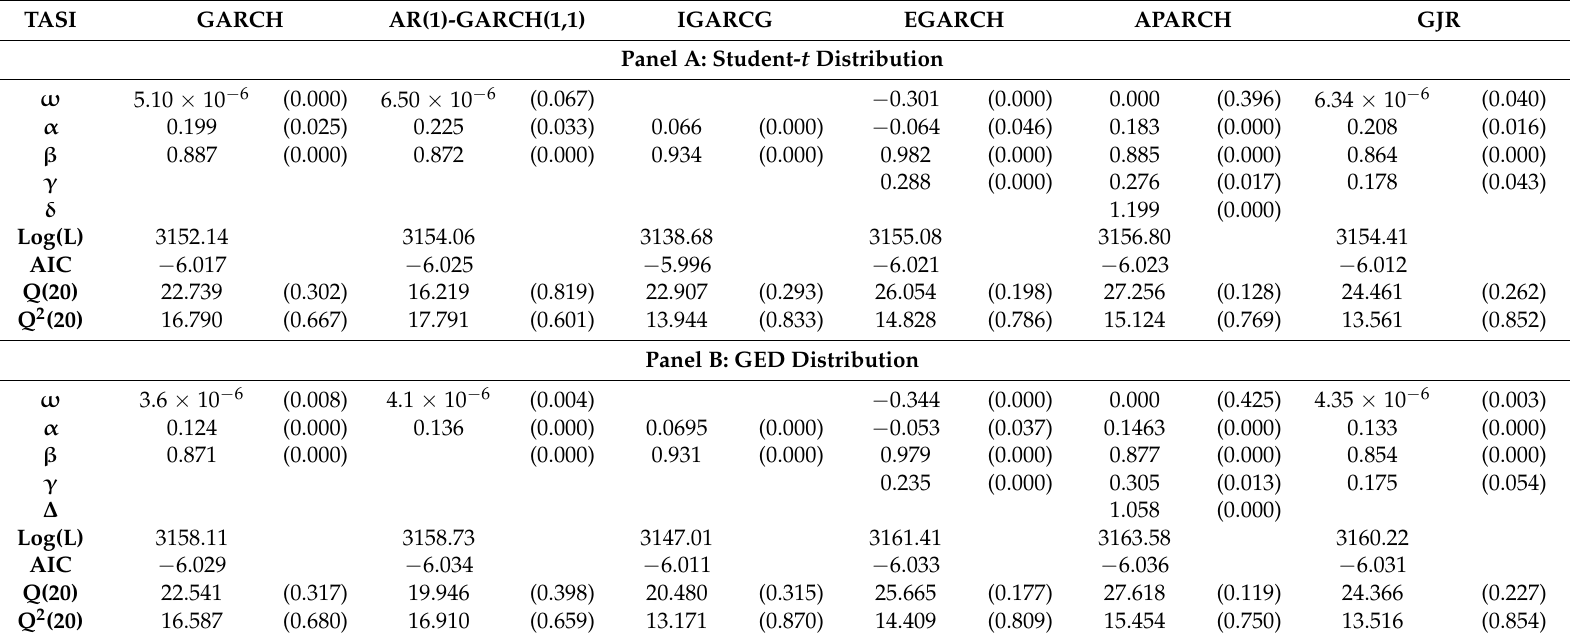
Table 2. Estimation results of different volatility models on the TASI. This table presents the in-sample estimation results for the different volatility models during the period of 10 September 2007 to 3 August 2014. Panel A presents the in-sample estimation results using Student- t distribution. Panel B presents the in-sample estimation results using GED distribution. Log(L) is the logarithm maximum likelihood function value. AIC is the average Akaike information criterion. Q(20) is the Ljung-Box Q-statistic of order 20 computed on the standardized residuals. Q 2 (20) is the Ljung-Box Q-statistic of order 20 computed on the squared standardized residuals. Numbers in parentheses are the p